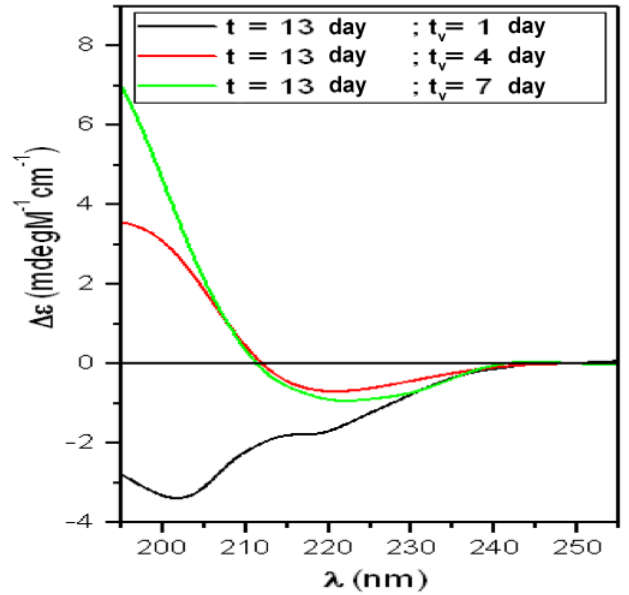
Figure 6. CD spectra relative to the sCT solution representing the “Growth-phase” (t = 13 days) in the presence of liposomes incorporating GM1 and Chol mimicking “lipid-rafts”. The solution was studied at room temperature and increasing lifespan (t v ). Table 3. Percentage of secondary structures obtained by the fitting procedure, relative to spectra of Figure 6.